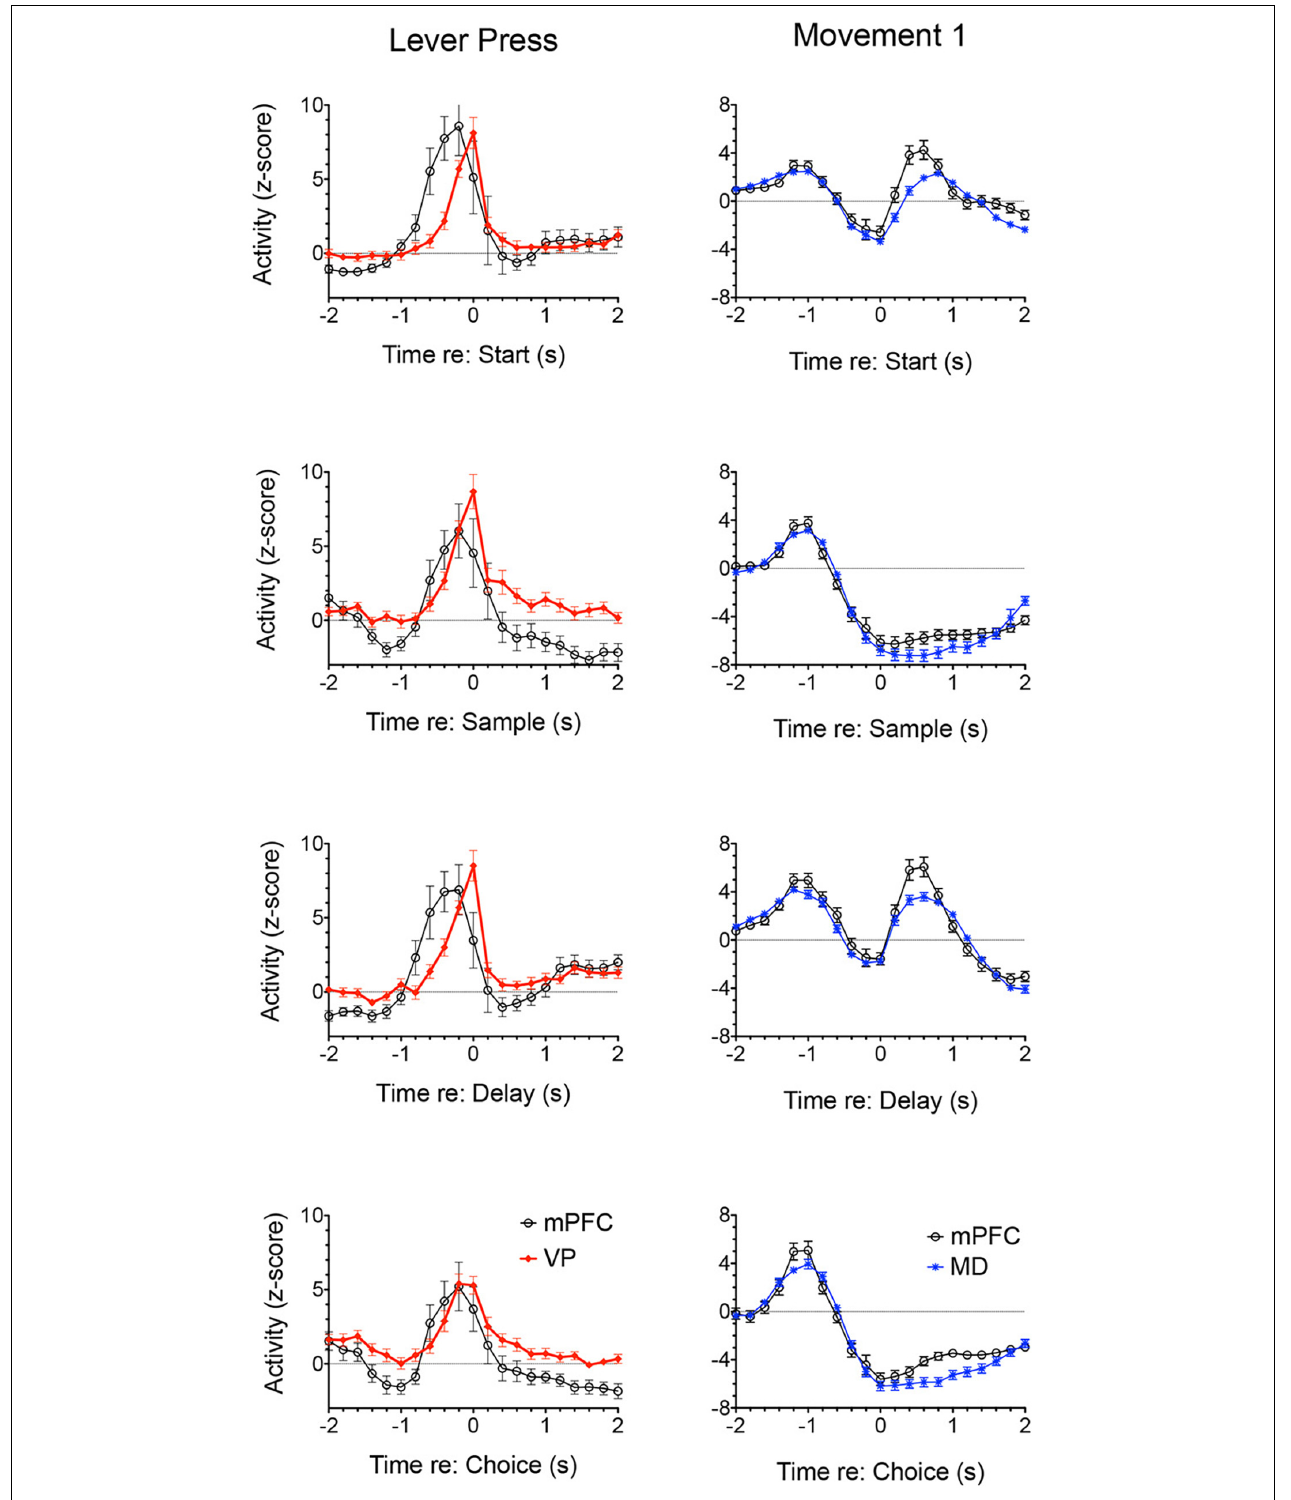
FIGURE 8 | Normalized population histograms comparing responses of neurons with elevated activity during each lever press in mPFC ( n = 28) and ventral pallidum (VP; n = 22) and neurons with elevated activity during movements toward each lever press for mPFC ( n = 97) and mediodorsal thalamus (MD; n = 91). Results are shown for all neuronal responses recorded for each response type with a minimum of 40 trials completed in a 60 m session. These were averaged for individual neurons and normalized so that each response recorded contributed equally to the population function. Error bars represent standard error of the mean.